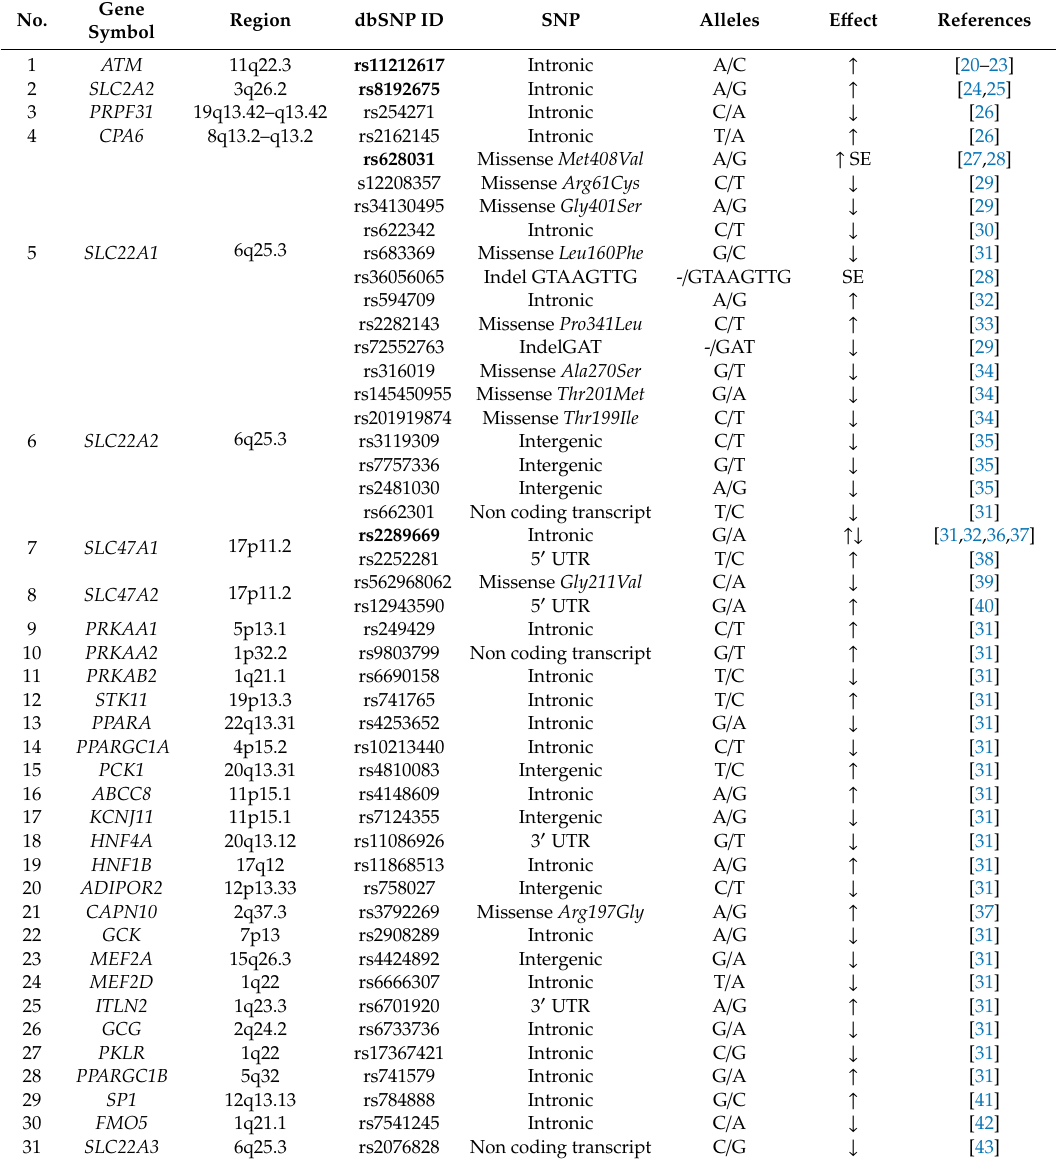
Table 1. Genetic variants that influence metformin therapy